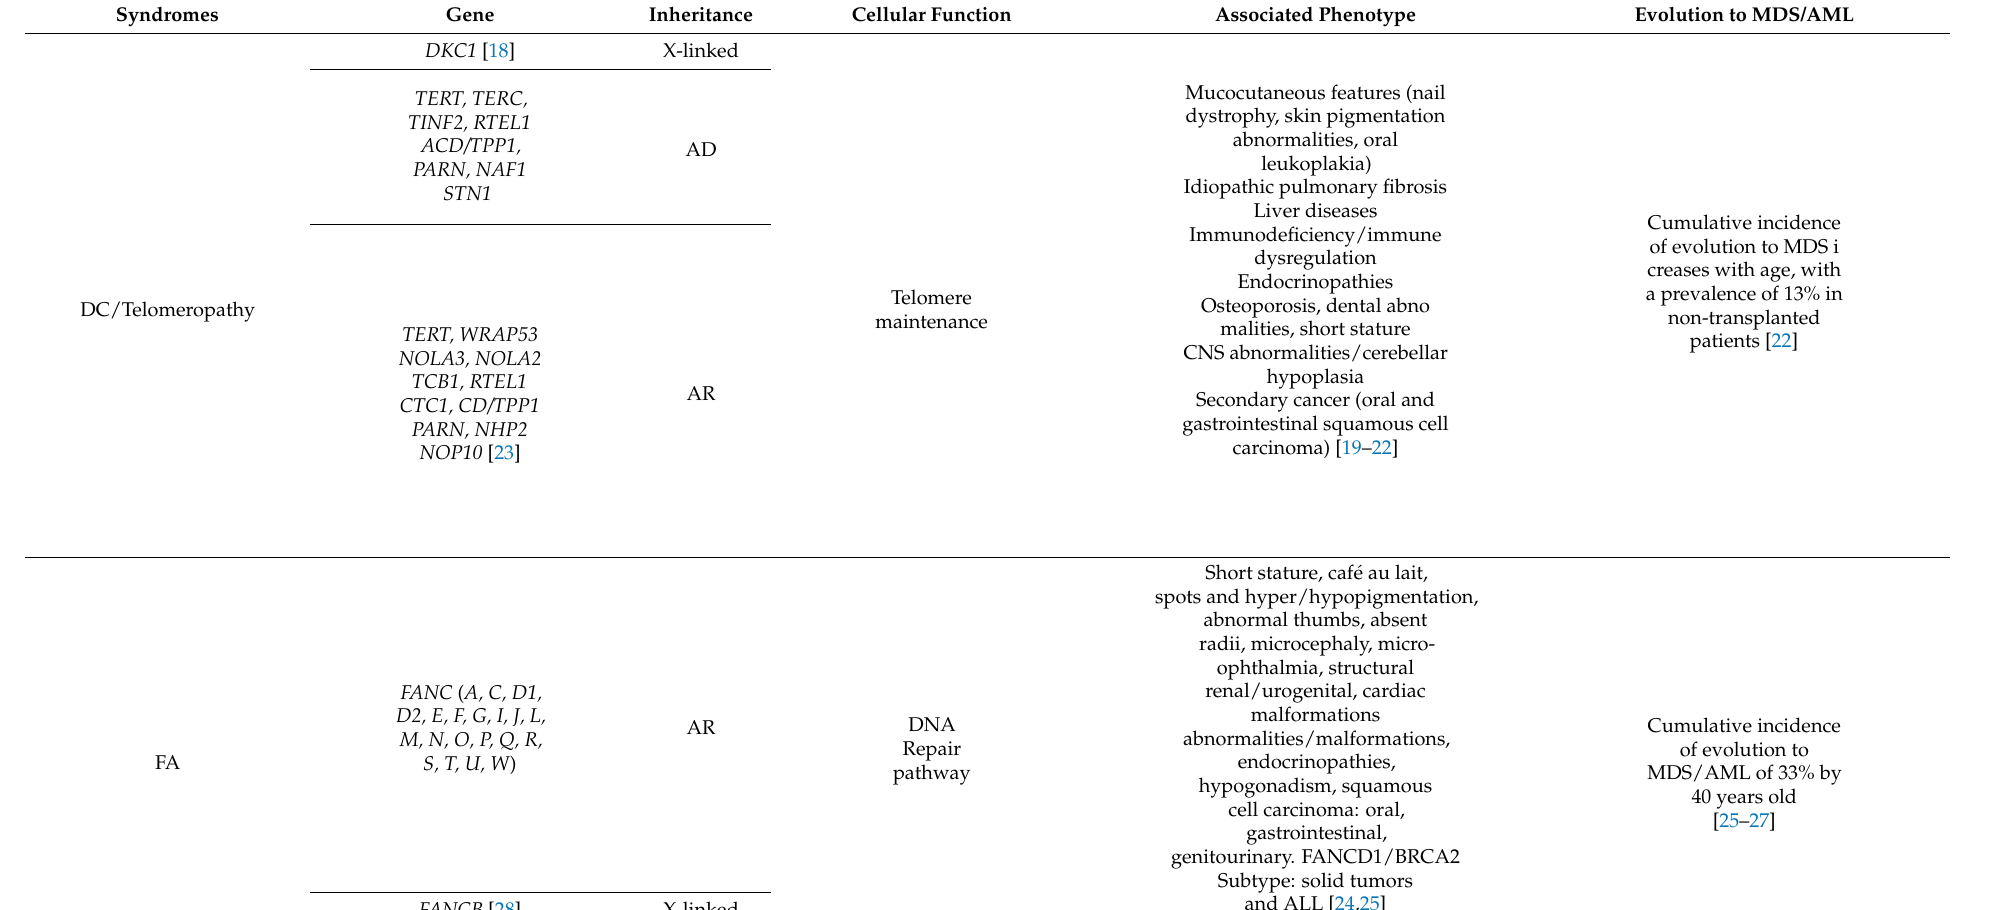
Table 1. Most common germline disorders associated with